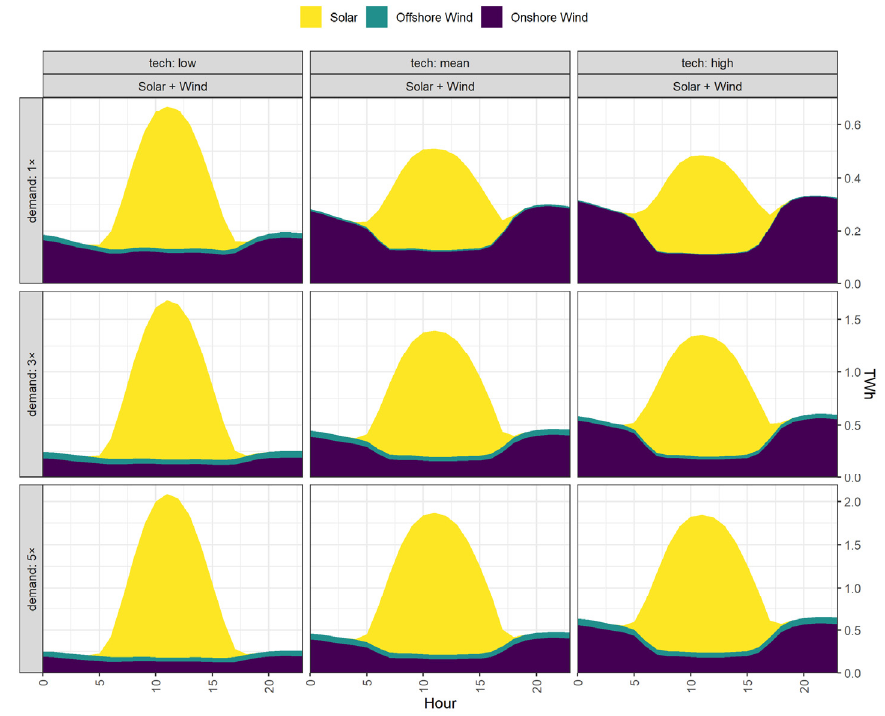
Figure A25. Intraday complementarity of wind and solar energy, national aggregate, scenarios without balancing technologies (‘none’), weather year 2020.